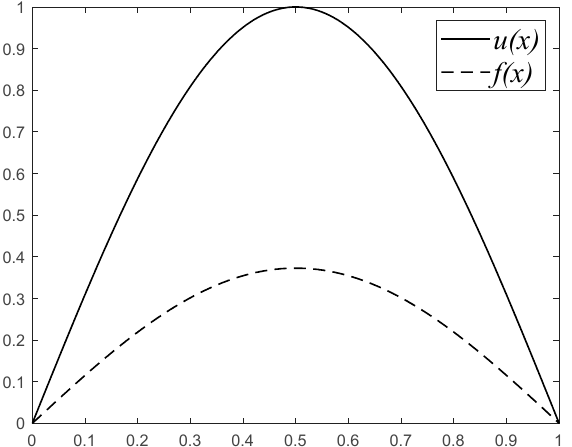
Figure 5. The exact solution for inverse problem and input function.